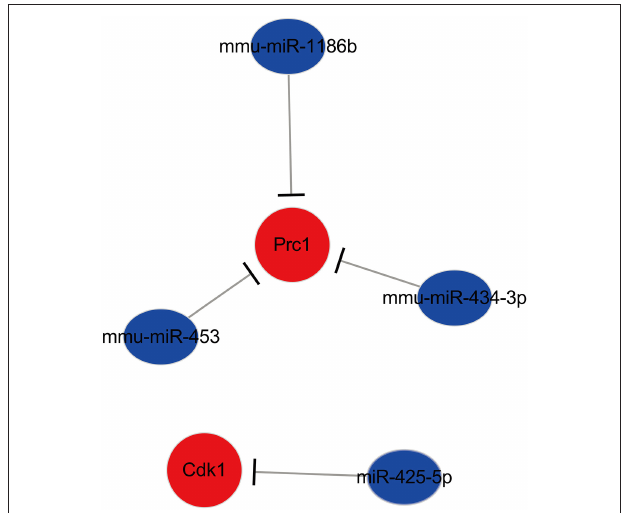
FIGURE 8 | The key miRNA–mRNA regulated network in ischemic stroke modified by EA